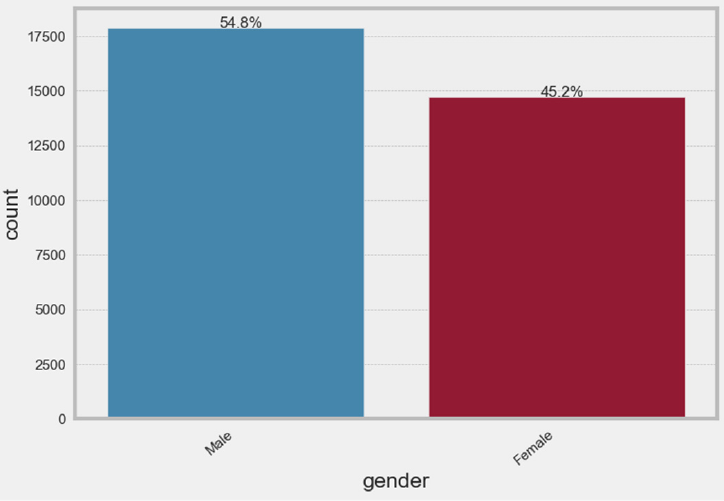
Figure 5. The Distribution of The Target Variable of Student Engagement.